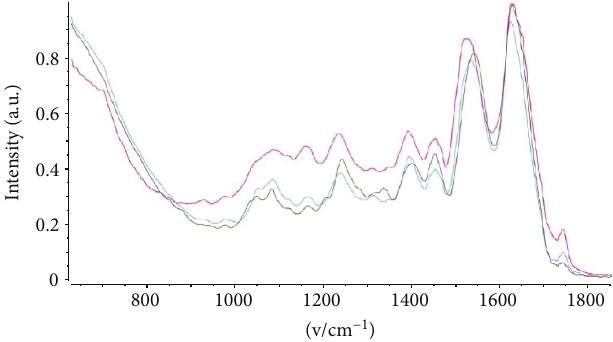
Figure 8: Comparison between the low-frequency FT-IR spectra of surface polymer coatings from areas of salmon adherence (pink spectrum) and those of salmon muscle (light blue spectrum) and skin (green spectrum).